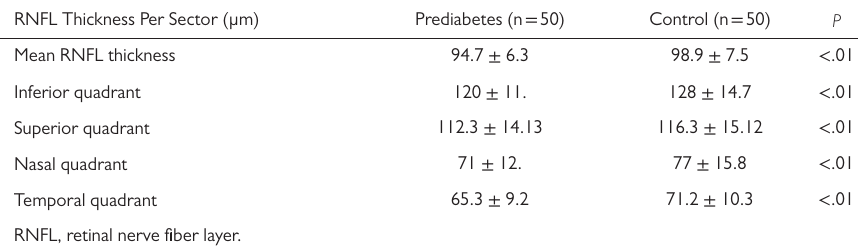
Table 1. Thickness Measurements of the RNFL in Patients with Prediabetes and Control